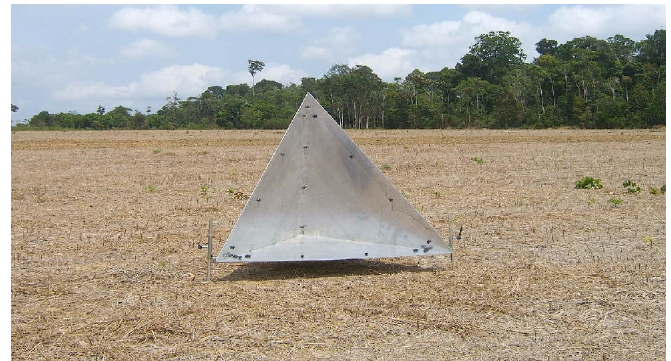
Figure 6. Corner reflector deployed in the Tapajós